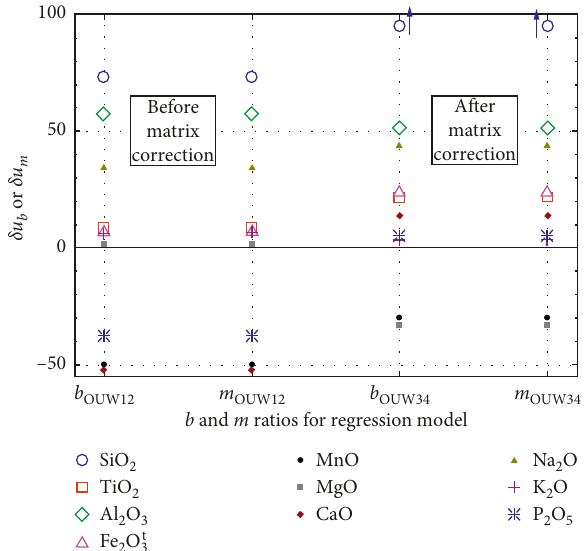
Figure 3: New parameters δ u u b (for the intercept) and δ m (for the slope) for the evaluation of intercept ( b ) and slope ( m ) of two regression models (OLR: ordinary least-squares linear regression and UWLR: uncertainty-based weighted least-squares linear re- gression) before (OUW12) and after (OUW34) the matrix cor- rection. The horizontal solid line at the y value of zero represents the line with no difference in the uncertainties of the two models. The arrows indicate that these data plotted above the scale are used for the diagram.